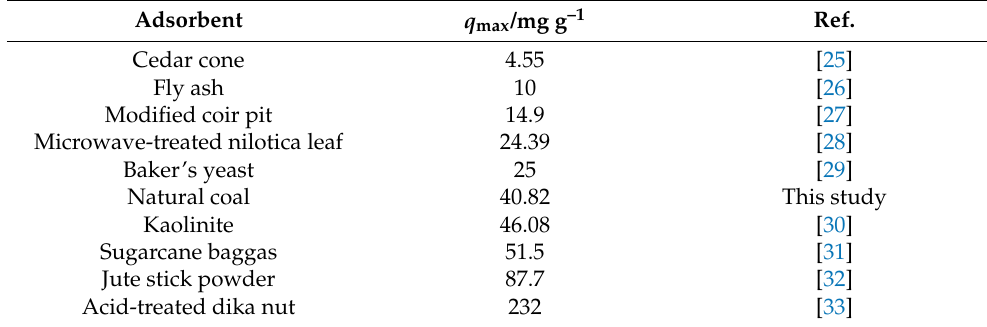
Table 3. Comparison of the maximum uptake of MB onto coal with that of various adsorbents.